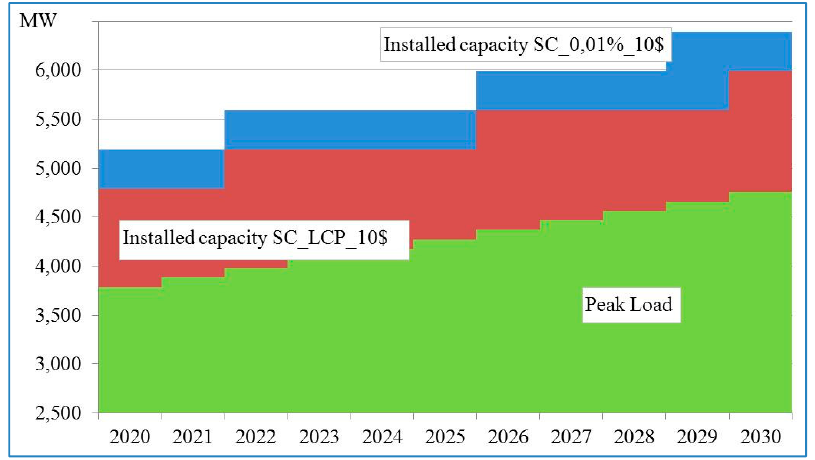
Figure 15. Scenario with VOLL $10 USD/kWh and LOLP = 0.01% versus the LCP scenario.